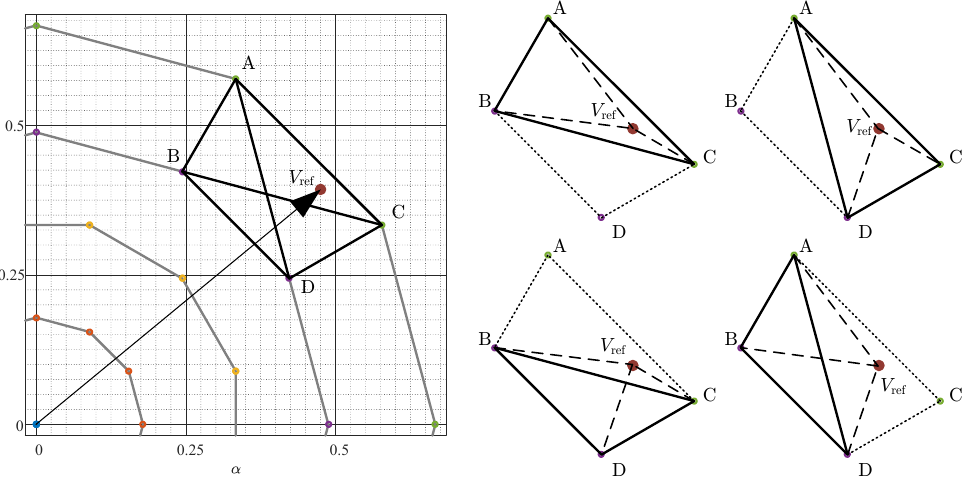
Figure 6. Example reference vector and its representation by means of barycentric